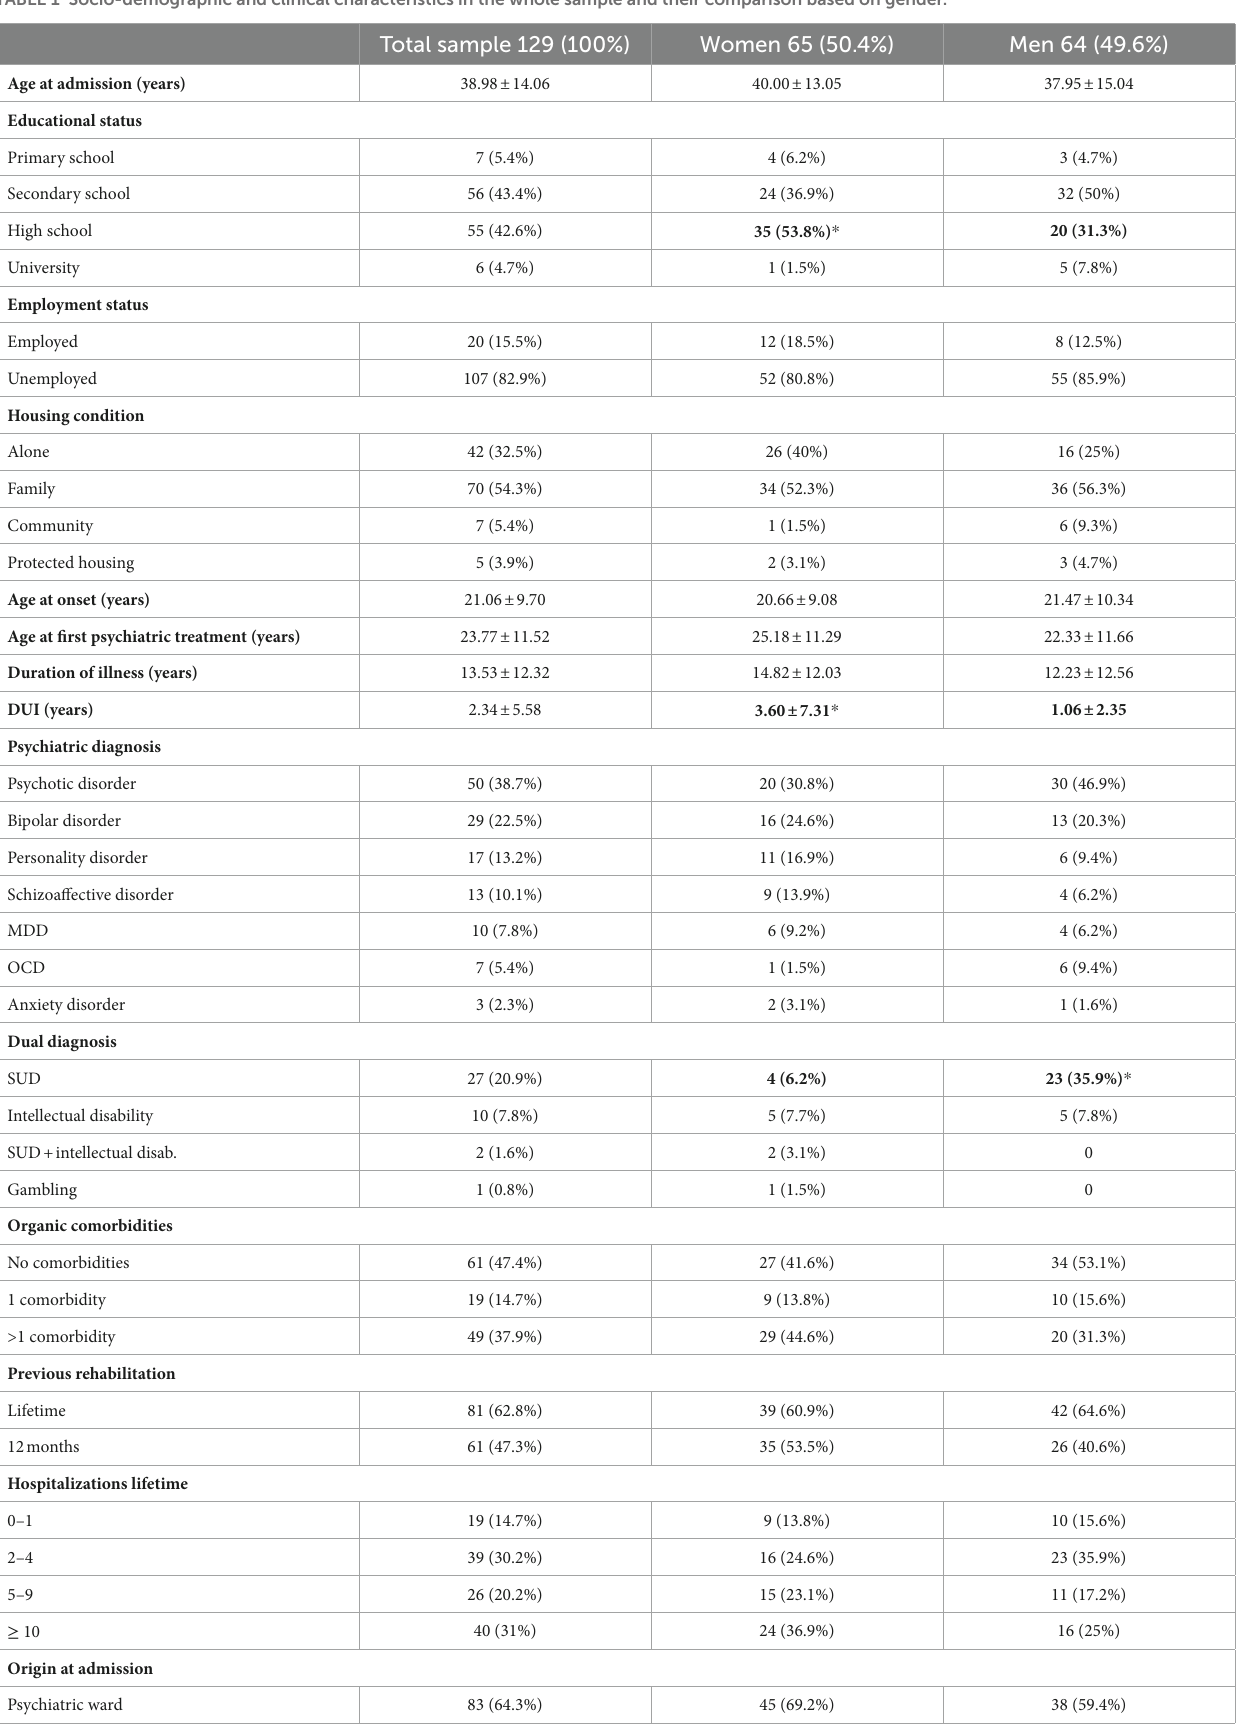
TABLE 1 Socio-demographic and clinical characteristics in the whole sample and their comparison based on